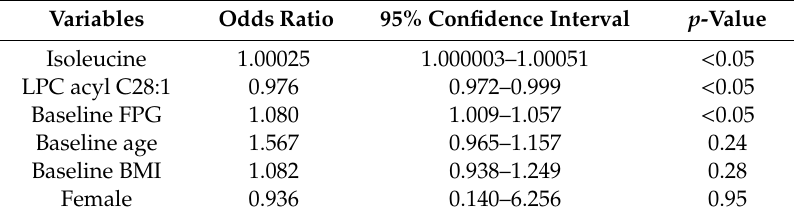
Note: FPG, fasting plasma glucose; BMI, body mass index. In the format Cx:y, x denotes the number of carbons in the side chain and y the number of double